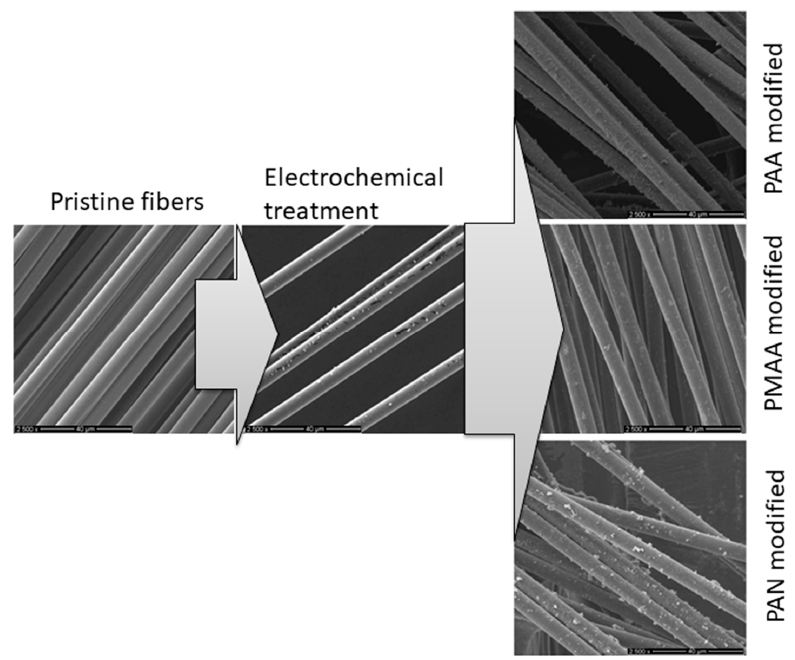
Figure 1. SEM images of carbon fibres, reproduced from [1].